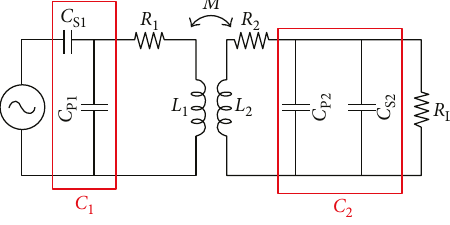
Figure 4: Circuit model of inductive coupling.